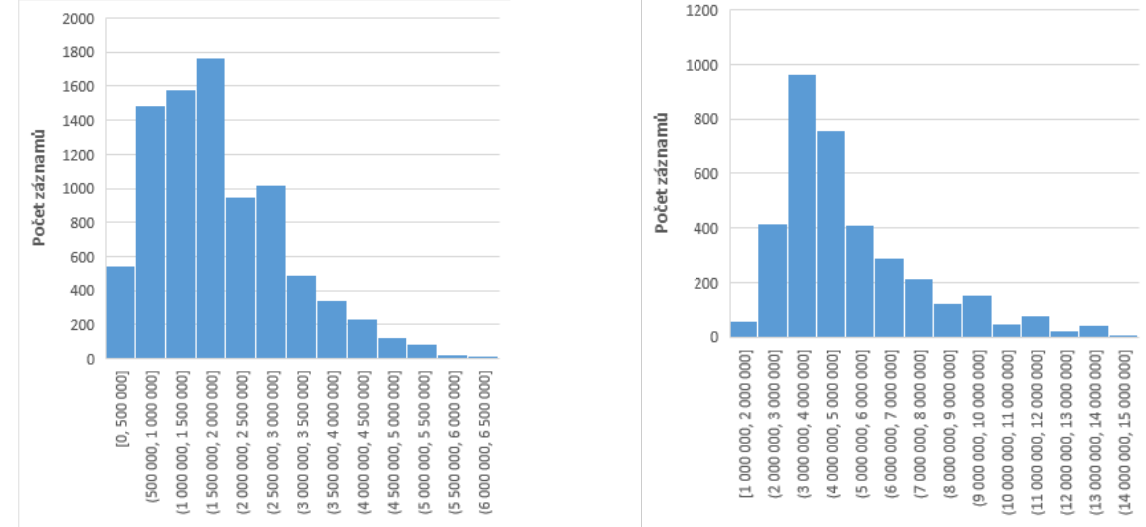
Graf 6 a 7: Cenové rozpětí u prodeje bytů - Česká republika bez Prahy (levý graf), region Praha (pravý graf), jsou použita data ze 44. a 45. týdne roku 2017 (zdroj: